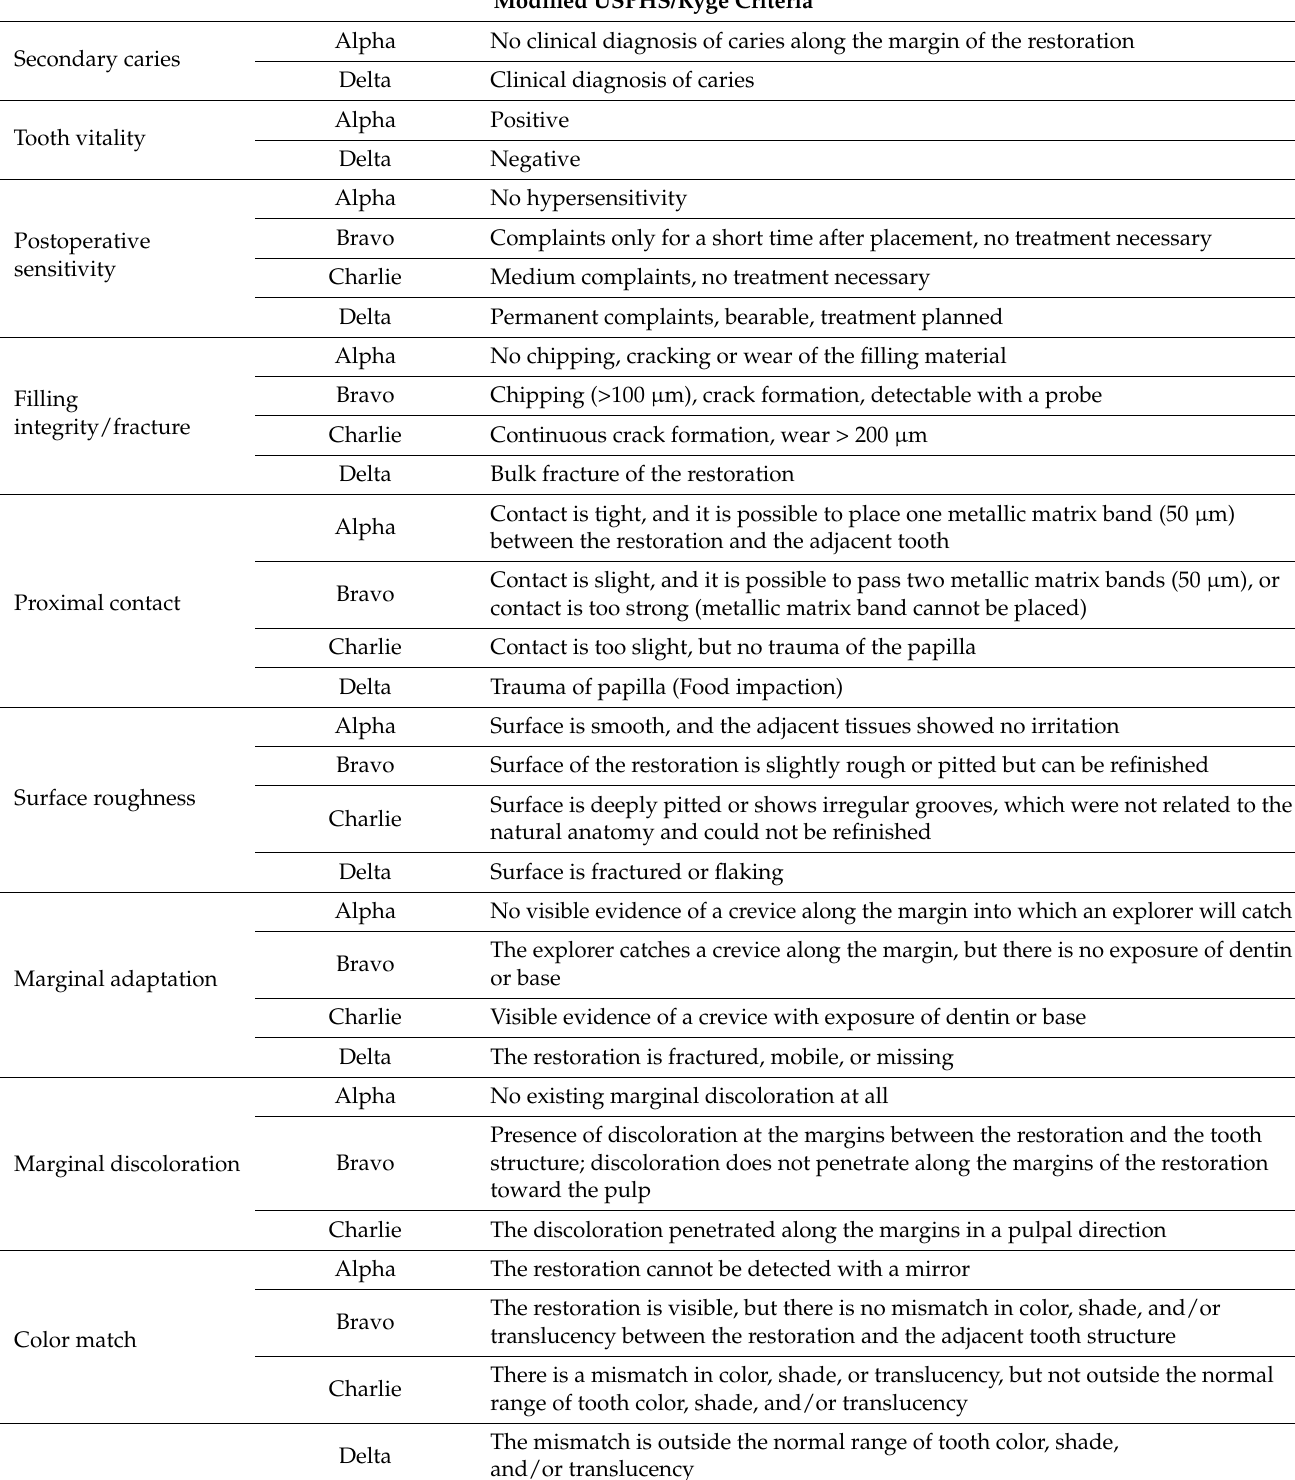
Table 2. Summary of the modified USPHS/Ryge criteria used for the clinical